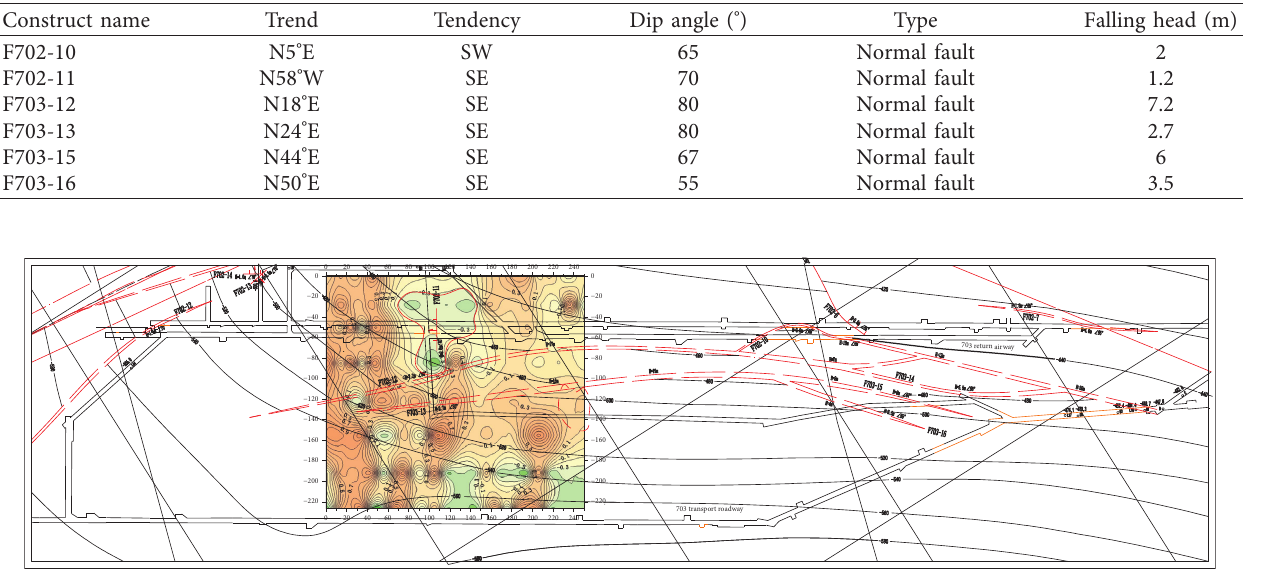
Figure 1: Distribution range of weak zone in 182703 working face.